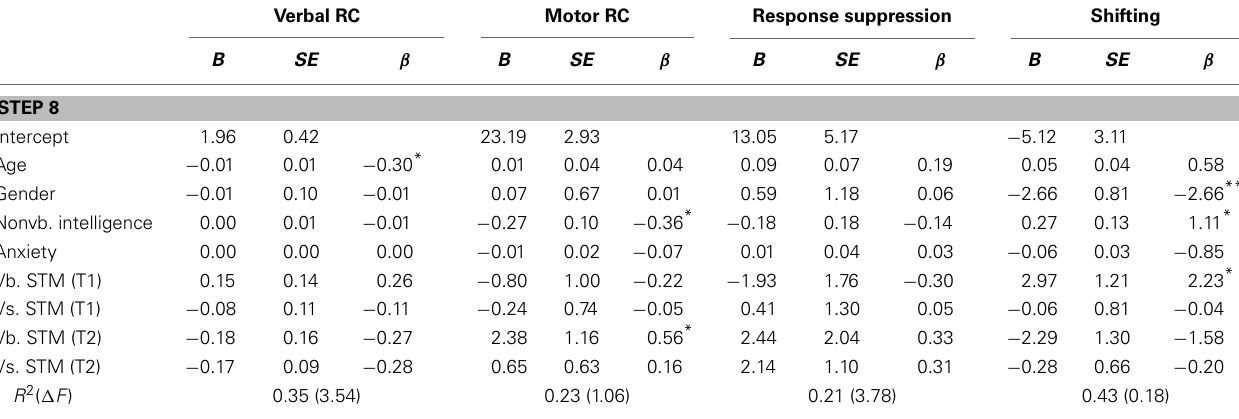
and all other (non-significant) continuous model predictors were set to the mean sample values. Vb., verbal; Vs., visuospatial; STM, short-term memory; WM, working